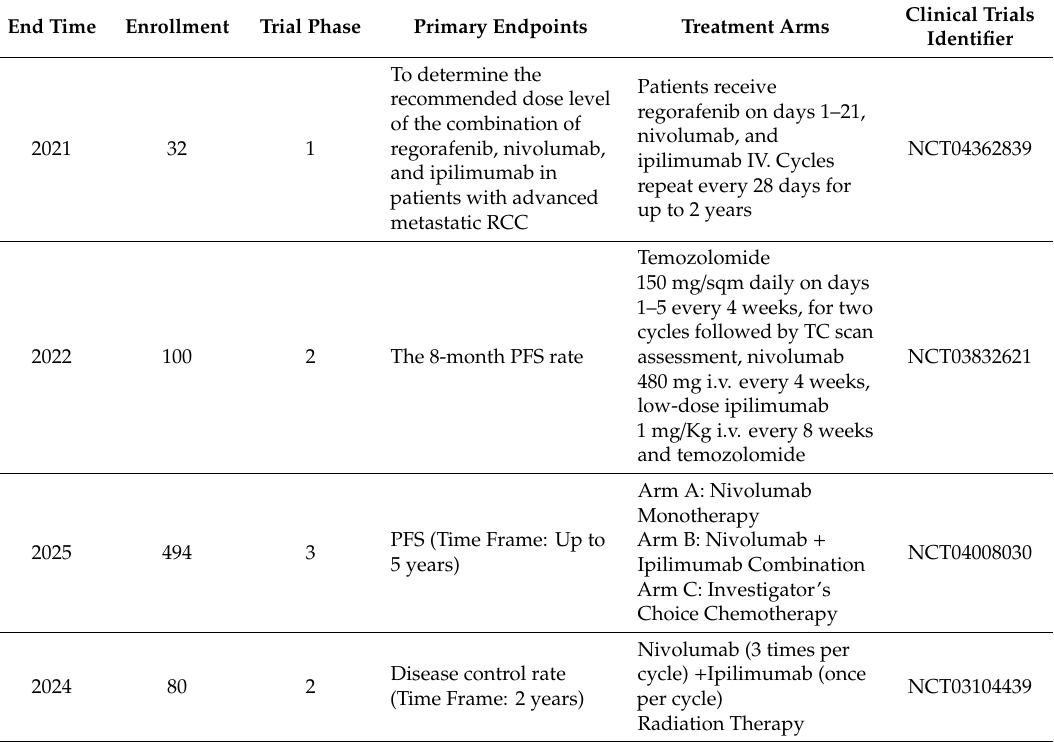
Table 3. Ongoing trials of ipilimumab plus nivolumab in Metastatic and Microsatellite Stable